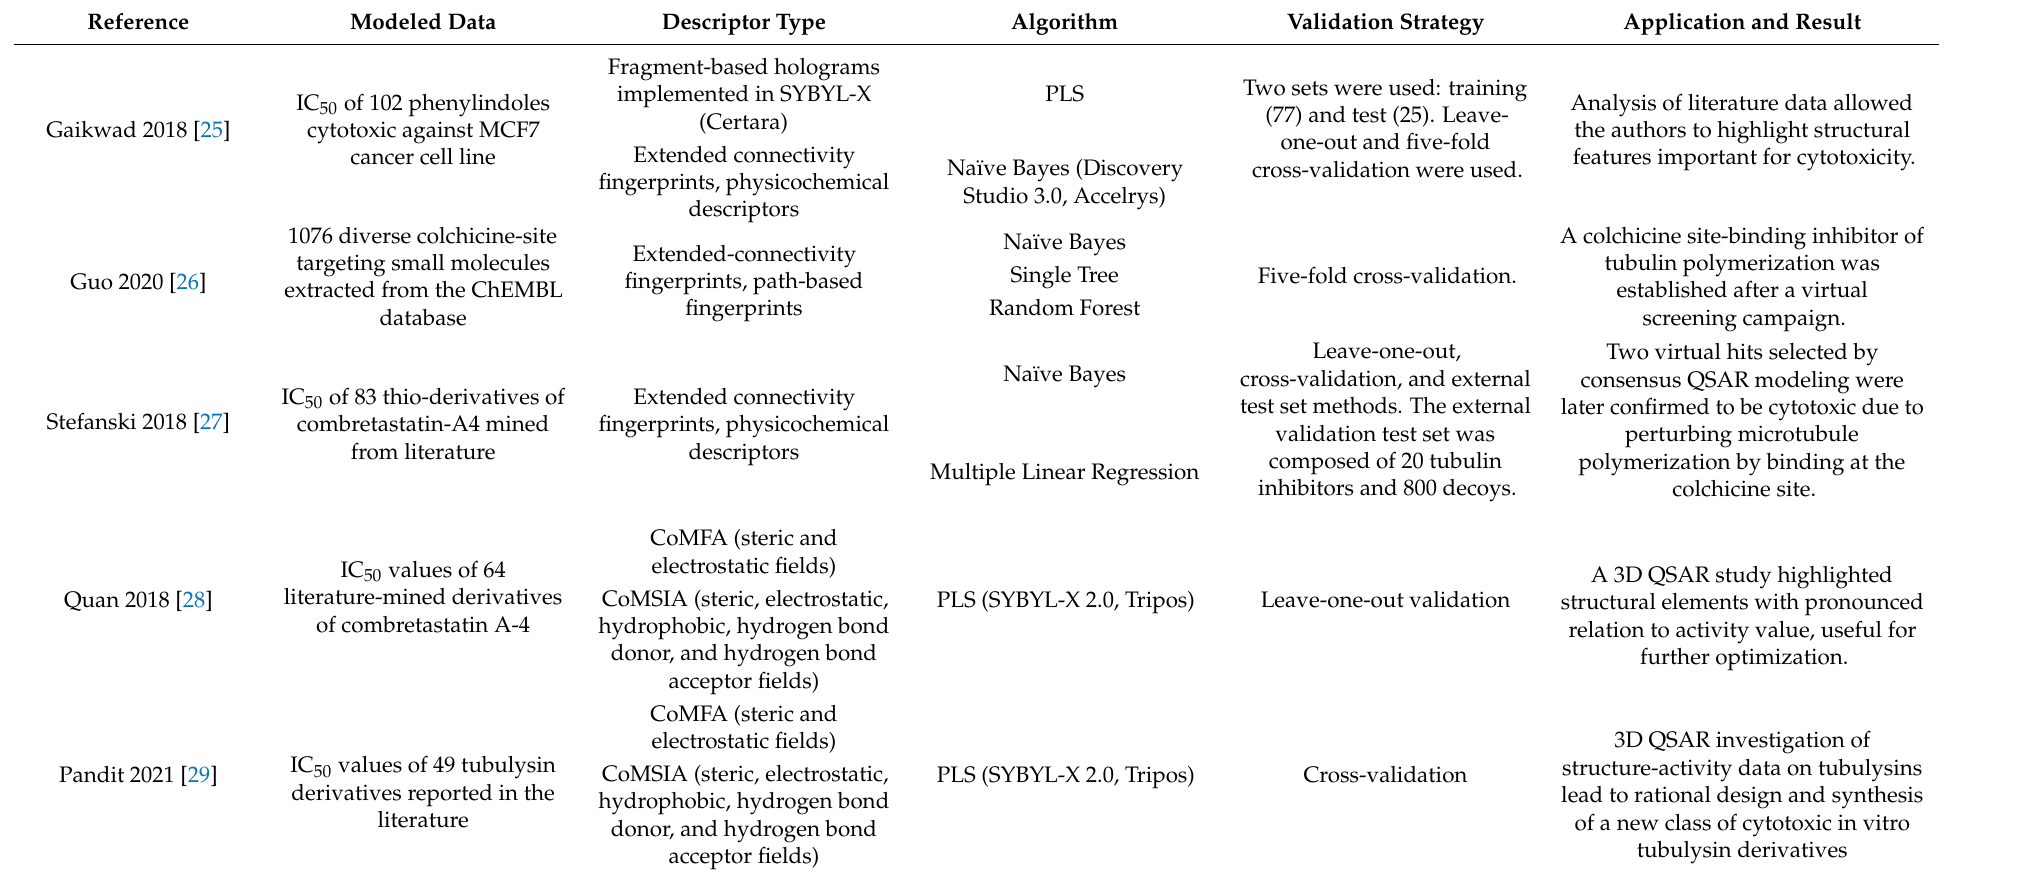
Table A2. Summary of recent ligand-based QSAR